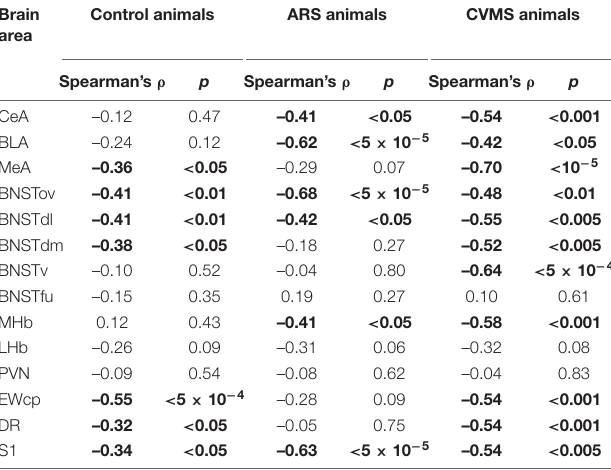
TABLE 3 | Summary of Spearman’s correlation